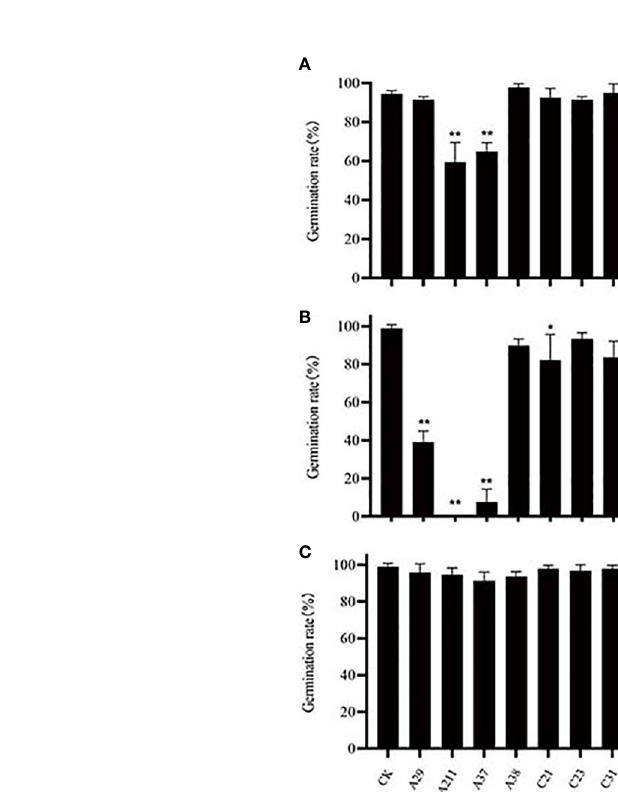
FIGURE 5 Effect of mVOCs on seed germination of Arabidopsis thaliana at varying incubating temperatures. (A) effect at 4°C; (B) effect at 10°C; (C) effect at 20°C. X-axis indicates yeast strains; Y-axis indicates seed germination rate; n=3; ‘ * ’ indicates P< 0.05, compared with water control at the same incubation temperature using Dunnett ’ s test; ‘ ** ’ indicates P< 0.01, compared with water control at the same incubation temperature using Dunnett ’ s test. Standard error indicated in error